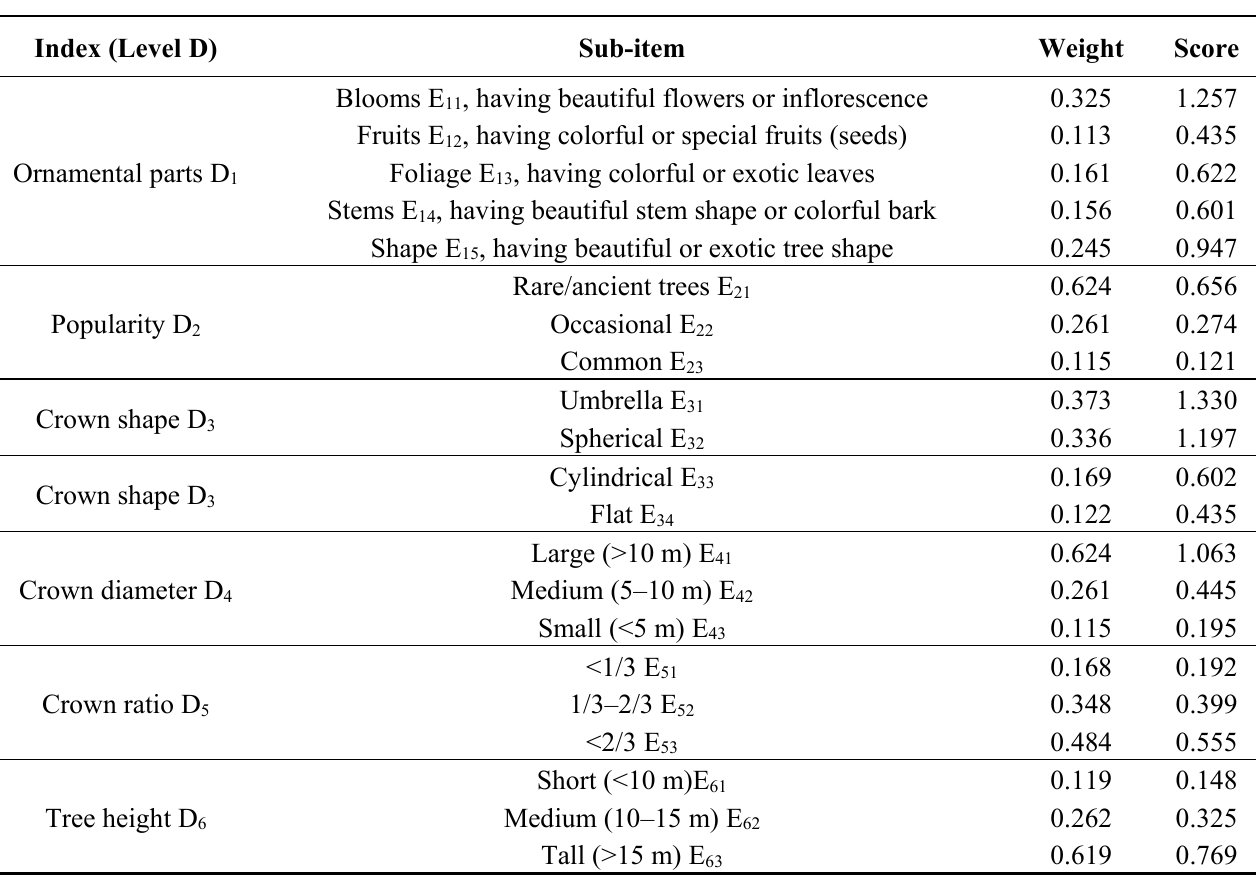
Table 3. Categories and scores of individual tree landscapes.